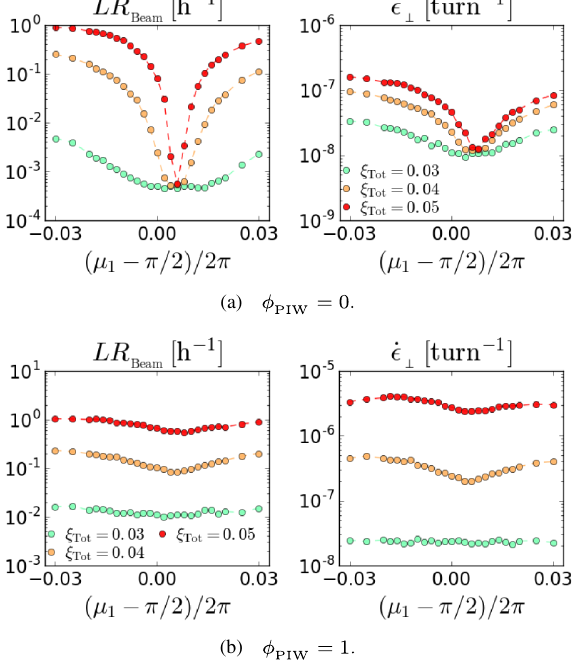
FIG. 16. Beam quality improvement for intermediate phase advance close to π = 2 , for different values of ξ Q 0 . 31 , Q 0 . 32 , and Q 0 ¼ 15 . x ¼ y ¼